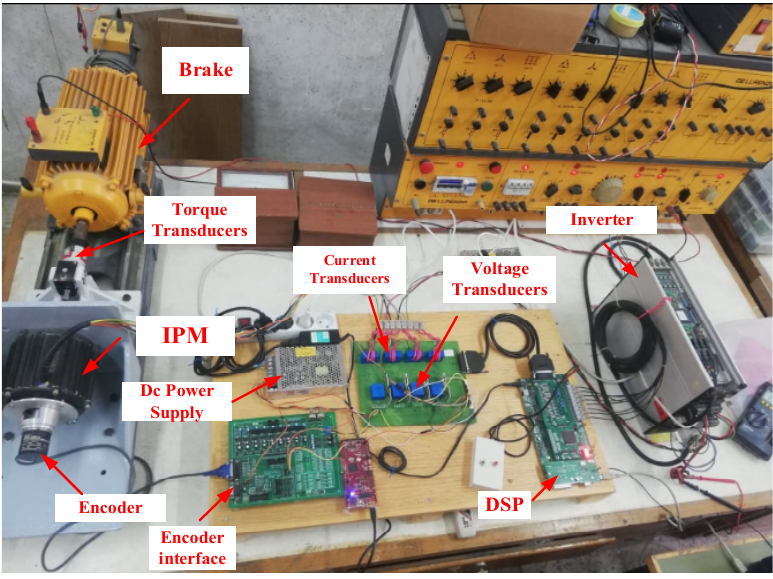
Figure 12. The practical implementation of the measurement platform.